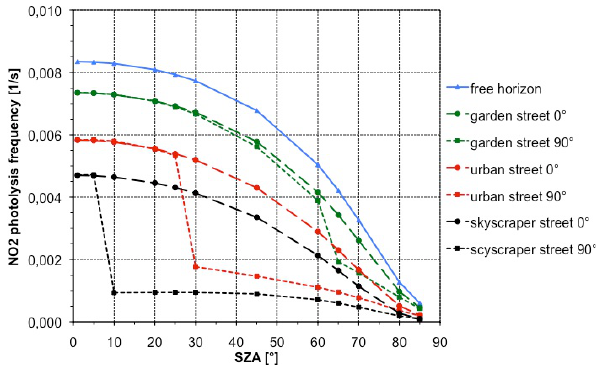
Fig. 5 J NO2 as function of the solar zenith angle for a cloud-free atmosphere with low and with high turbidity and for a cloud obscuring the sun for undisturbed conditions with free horizon and for an urban street with orientation parallel ( φ = 0°) and perpendicular to the sun ( φ = 90°). The related street NO J in Fig. 5 are shown for an urban street canyon with parallel and with per- 2 pendicular illumination. As in Fig. 4, the effect of shadow is evident for cloud-free conditions. The reduction for shadow conditions is less pronounced for high turbidity than for low turbid- ity, due to the sky radiation that increases with turbidity. For the conditions with the cloud layer both azimuth directions of the street result in the same values, since only diffuse radia- tion exists and thus no shadow due to the buildings occurs.